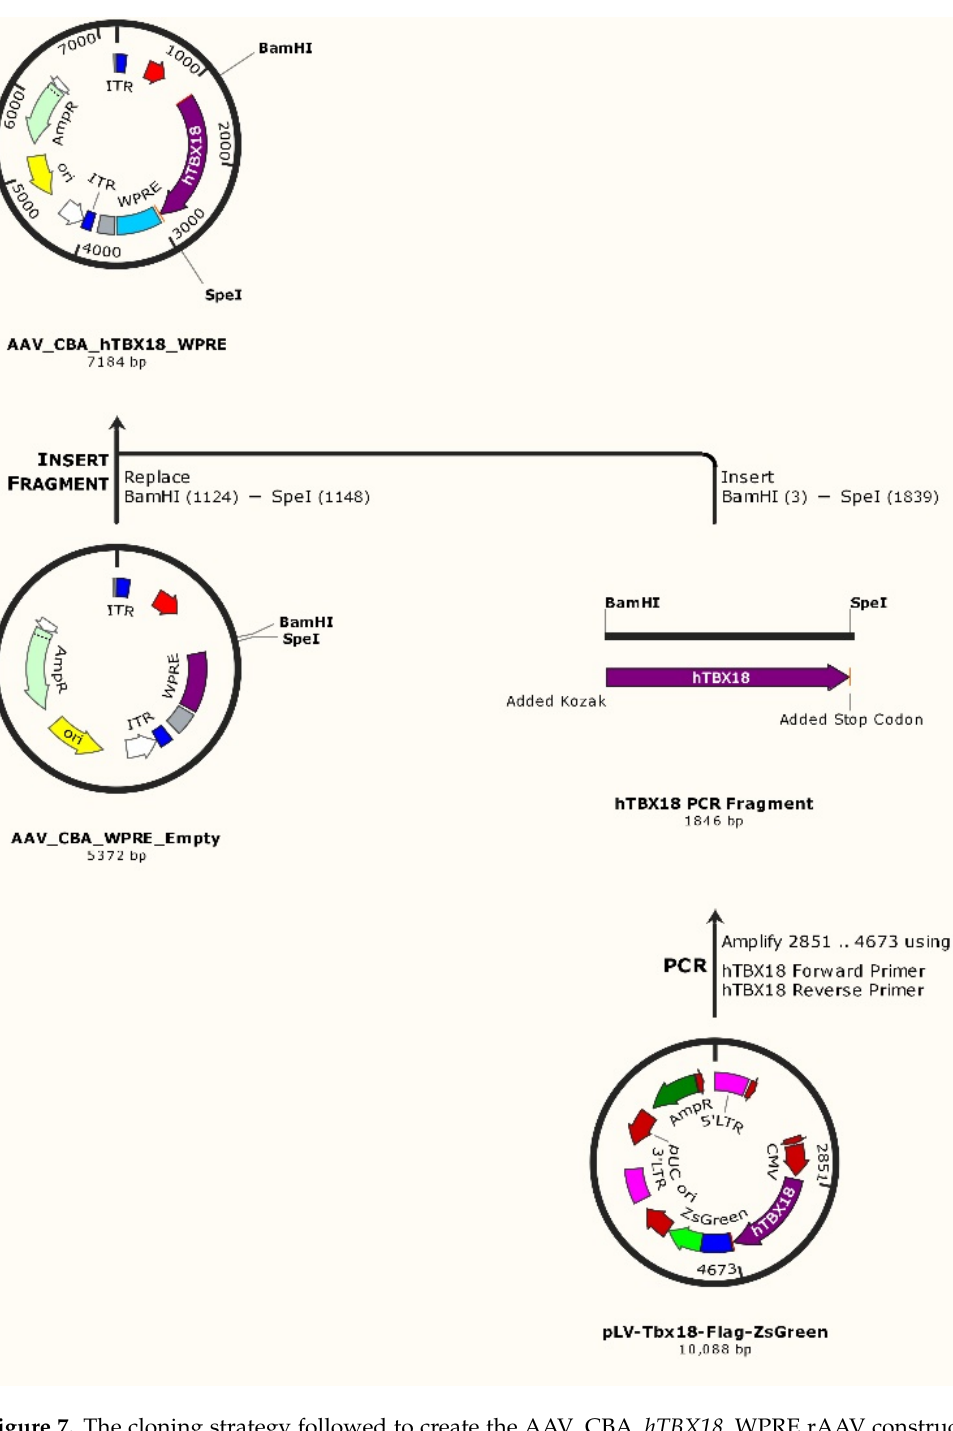
Figure 7. The cloning strategy followed to create the AAV_CBA_ hTBX18 _WPRE rAAV construct. This involved PCR amplifying the hTBX18 gene fragment from a lentiviral backbone and sub-cloning it into the rAAV construct.